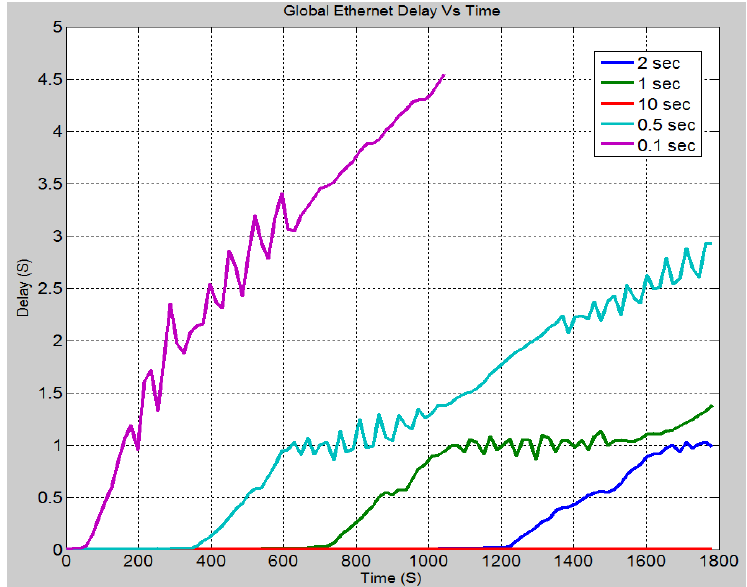
Figure 16. Case 4: Global Ethernet delay (s) for different inter arrival time.